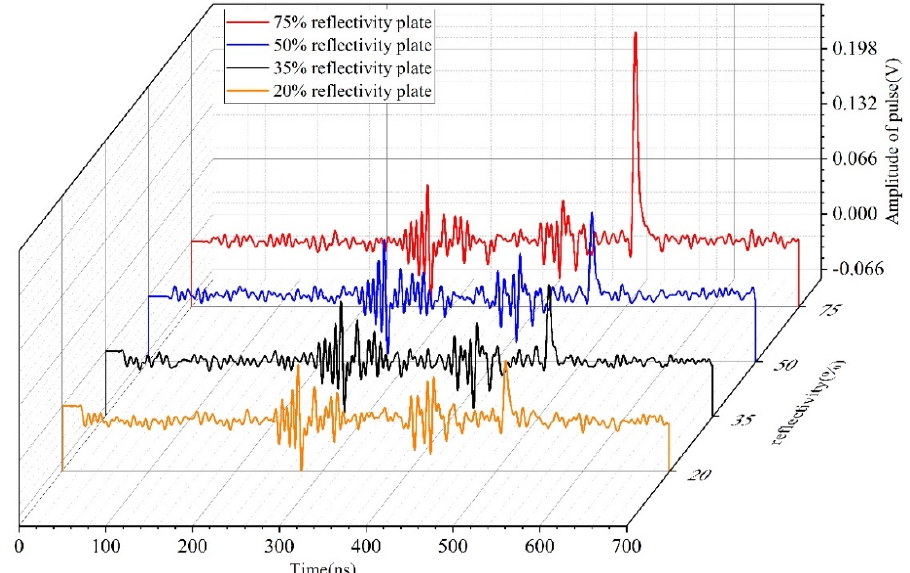
Figure 7. Echo pulse of different reflectivity targets at 20 m.